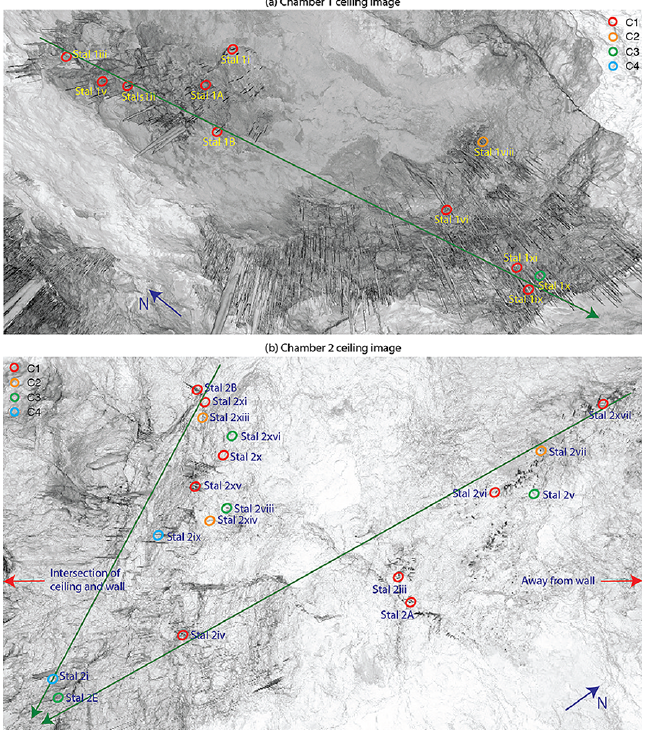
Figure 6. Cluster group plot overlaid upon the cave ceiling for both chambers. The ceiling images are captured by lidar and the circles represent the ceiling locations of stalactites dripping on various stalagmites in both chambers (shown in Fig. 1). The color of the circles indicates individual MDS cluster group. The blue arrows in both figures show the geographic orientation and the green arrows represent the approximate transects throughout the chambers from higher to lower ceiling